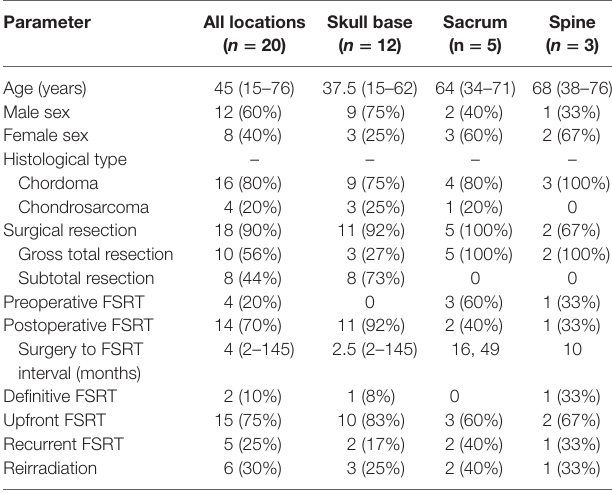
Table 1 | Clinical characteristics and fractionated stereotactic radiotherapy (FSRT) usage in chordoma and chondrosarcoma